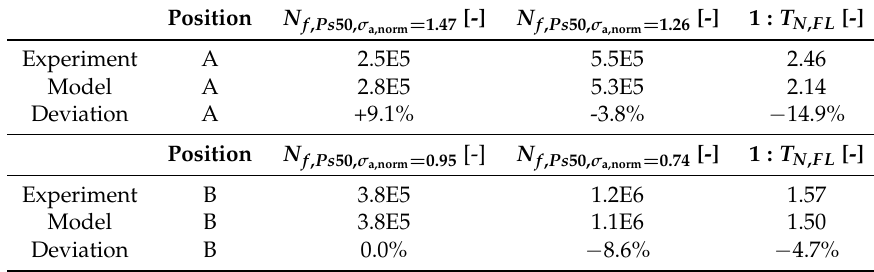
Table 5. Validation of the fatigue assessment model in the finite-life region (FL). Position N f , Ps 50, σ [-] N f , Ps 50, σ a,norm = 1.47 a,norm = 1.26